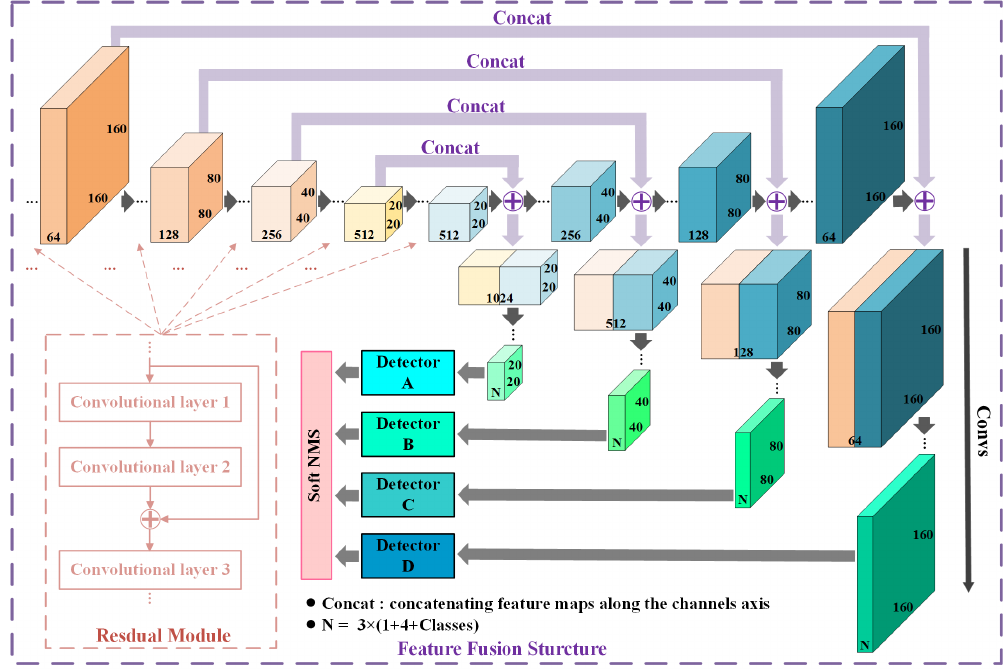
Figure 5. Feature fusion structure. Concatenation operation and corresponding convolutional operations are employed four times in NEOON to achieve feature fusion. Note that residual modules are adopted to accelerate and optimize the fitting process of the model. Subsequently, four detectors in increasing layers access the progressively fused feature maps, all four